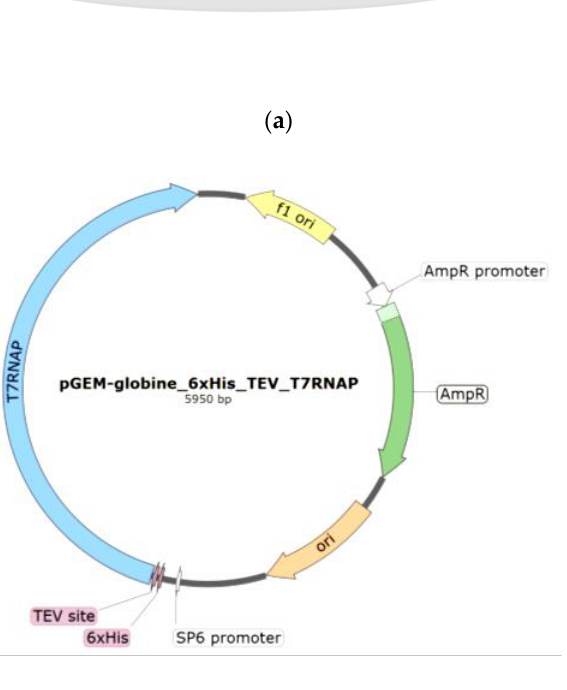
Figure 1. Cell-free “coupled 2 ” transcription–translation system. ( a ) Scheme of the cell-free “coupled 2 ” transcription–translation system. ( b ) Map of the plasmid encoding the human beta-globin 5′UTR, the T7 RNAP coding sequence containing a 6xHis tag, and a subsequent TEV protease site at the N-terminus.